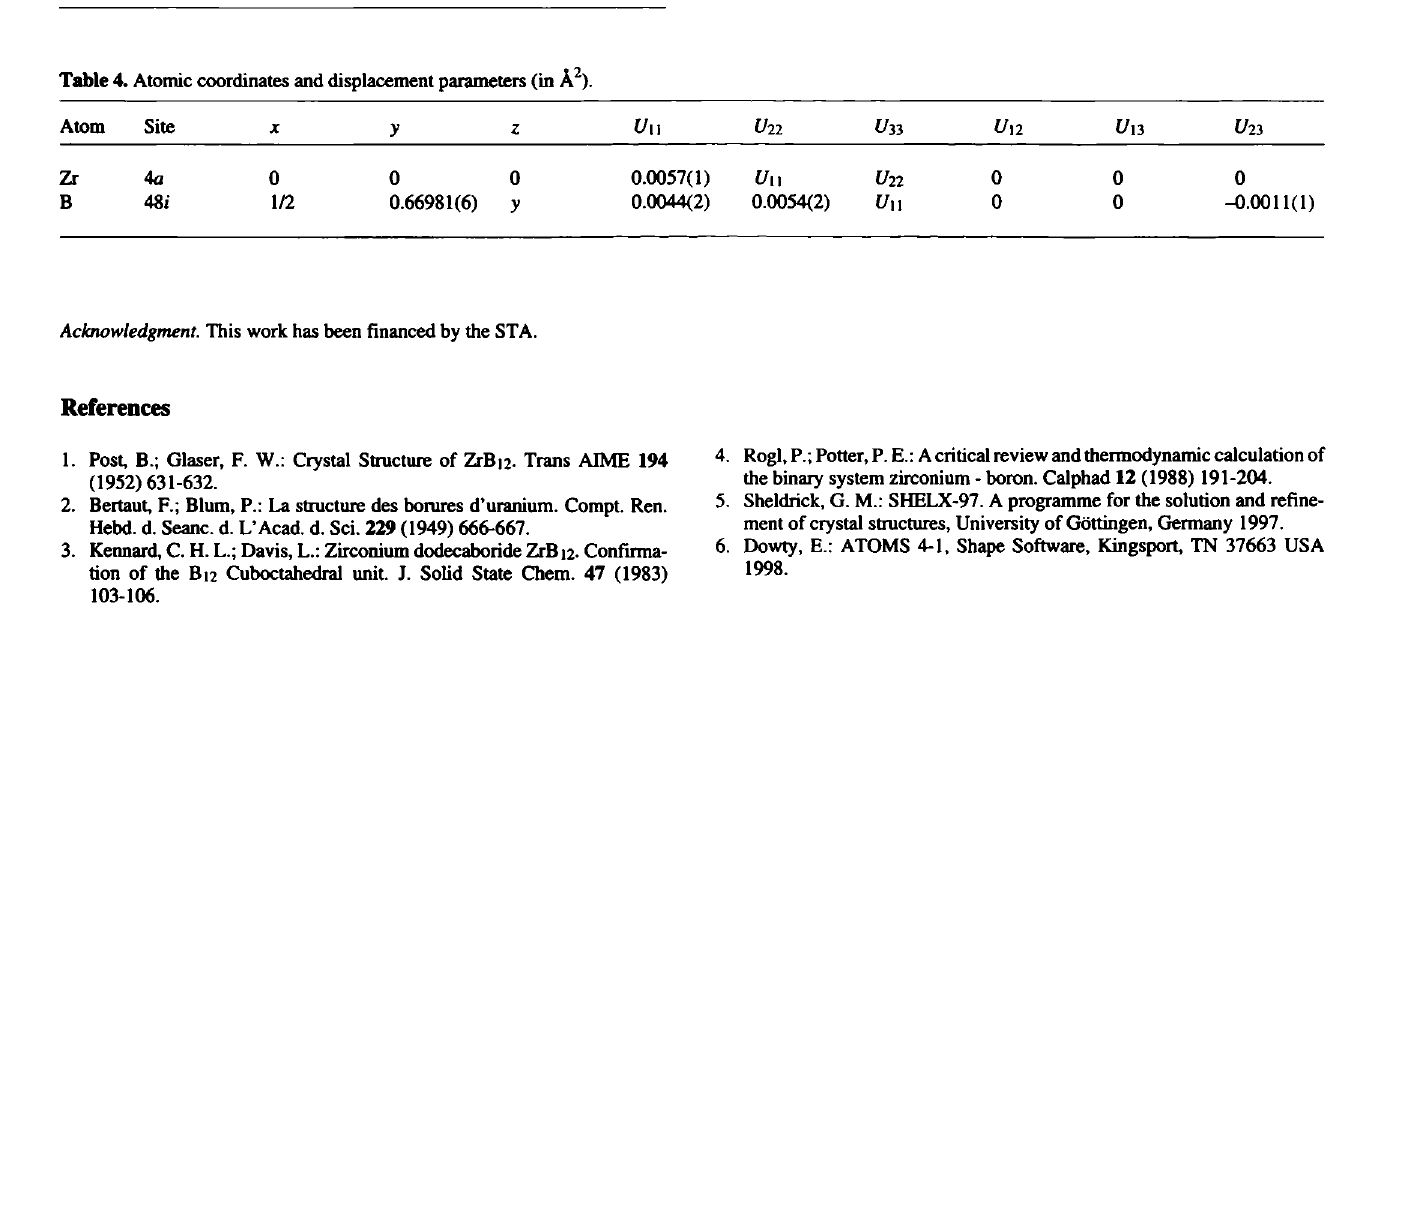
Table 4. Atomic coordinates and displacement parameters (in Ä 2